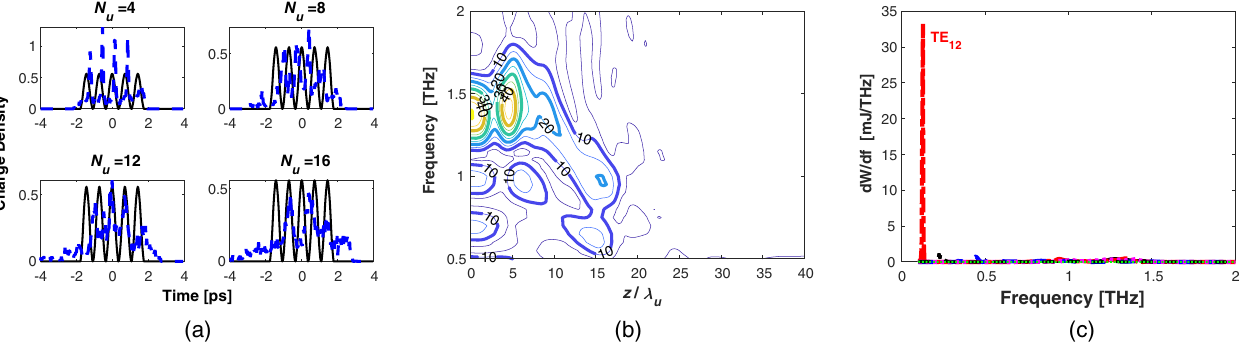
FIG. 7. Bunch with a charge of 2.5 nC and five periods of unity modulation at a frequency of 1.4 THz in the positive mass regime (under-resonance guiding field of 33 kG): (a) charge density after 10 to 40 undulator periods, (b) contours of the bunching factor, and (c) radiation spectrum after 40 undulator